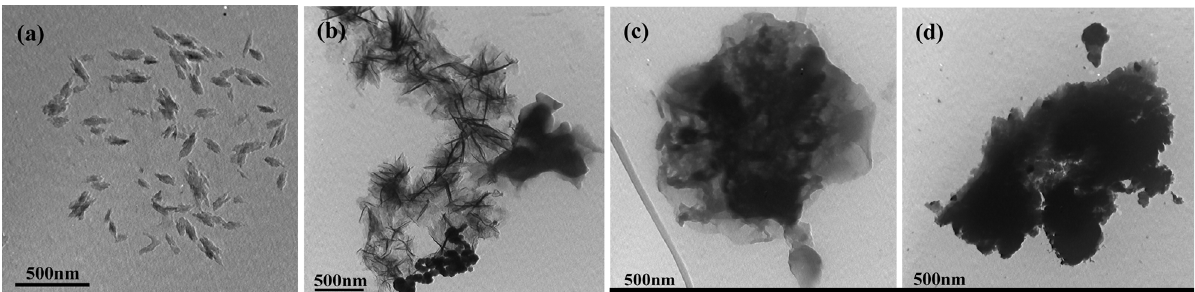
/TiO ; ( c ) poly(TPT)/TiO 2 2